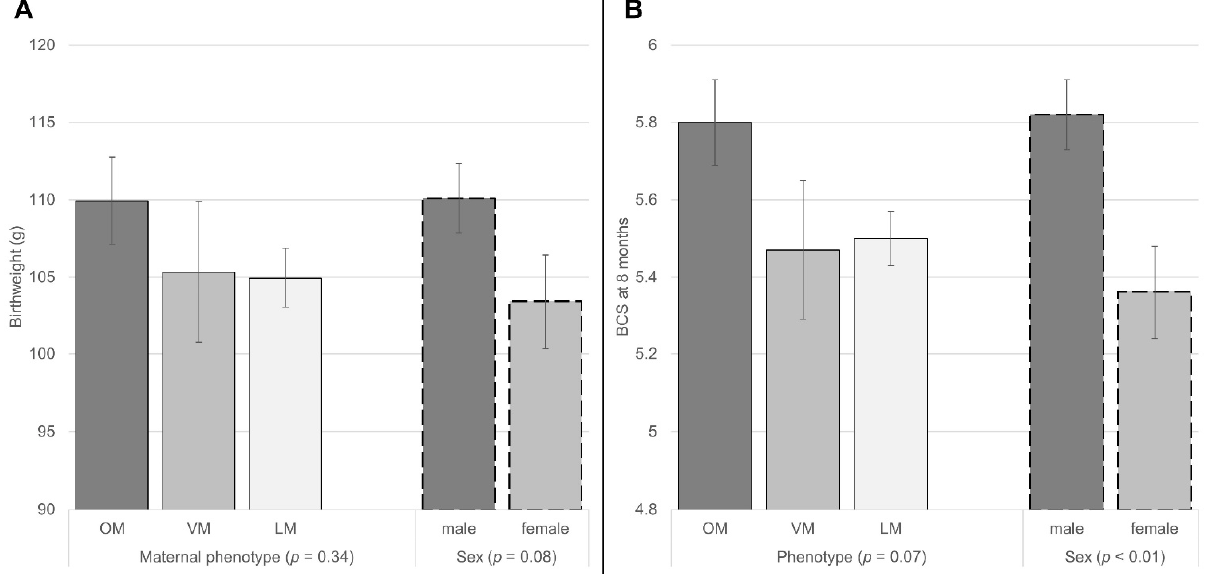
Figure 2. Two-way ANOVA analysis results with independent variables: sex and phenotype, dependent variables: ( A ) birthweight and ( B ) body condition score (BCS) at 8 months (used observations: 85 for both). Columns and brackets show the least square means and their standard errors respectively. Respective p -values are depicted per categorization group. p < 0.05 was considered significant. ANOVA results for dependent variables: mortality within the litter, and the number of reared kittens are not shown due to a lack of trends or significance. The interaction of phenotype and sex was always at p ≥ 0.41.